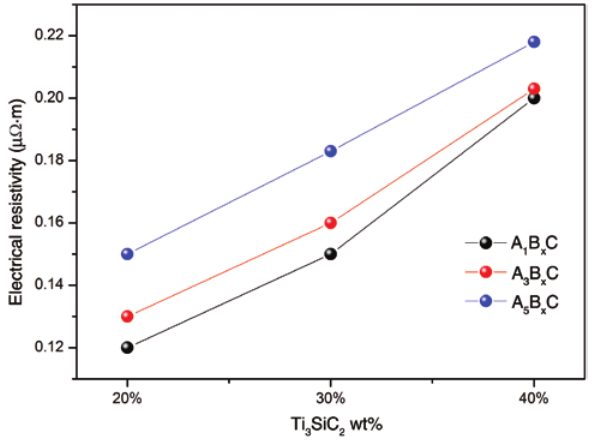
SiC /Al O HRCP. 3 2 2 3